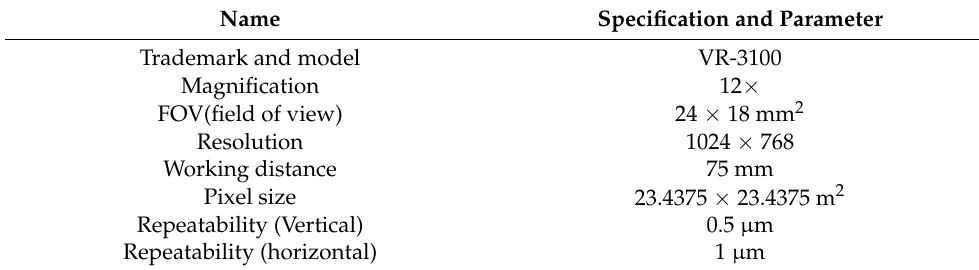
Table 2. Specification of optical profilometer VR-3100.